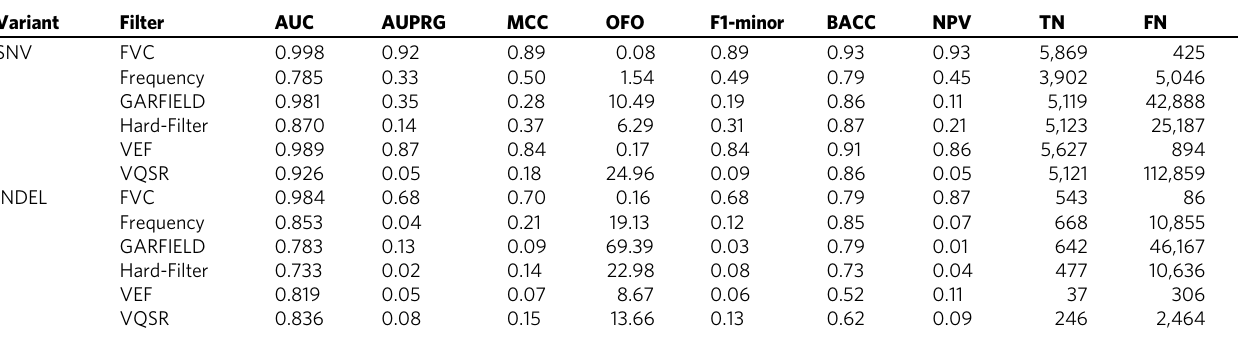
Table 1 The average performance of fi ltering methods when applied to the whole-genome sequencing datasets (HG001, HG003, HG004, and HG006) at 30× coverage and identi fi ed by GATK HaplotypeCaller.